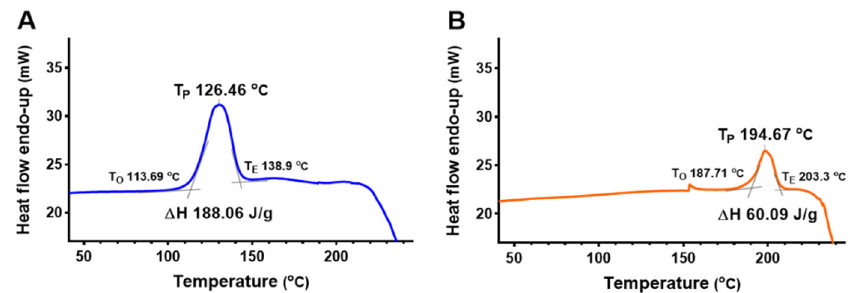
Figure 5. Differential scanning calorimetry profiles of D -psicose ( A ) and di- D -psicose anhydride ( B ).